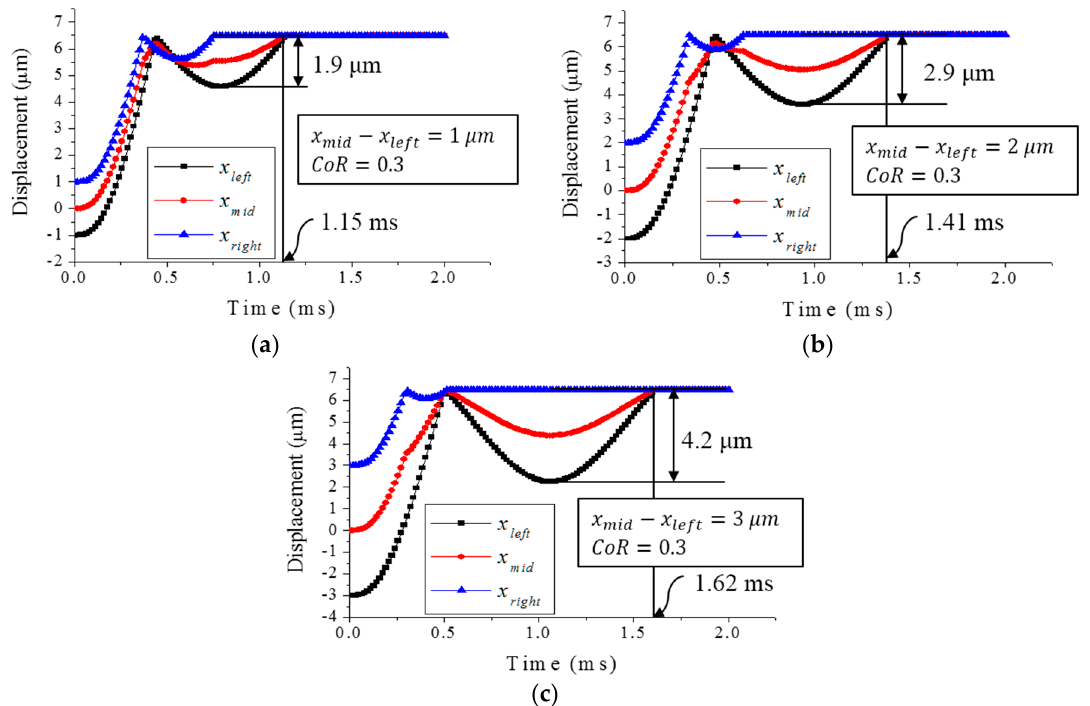
Figure 3. Analysed displacement of (cid:1876) (cid:3039)(cid:3032)(cid:3033)(cid:3047) (black square), (cid:1876) (cid:3040)(cid:3036)(cid:3031) (red circle), and (cid:1876) (cid:3045)(cid:3036)(cid:3034)(cid:3035)(cid:3047) (blue triangle). Each graph shows the result of vertical heights difference ( (cid:1876) (cid:3040)(cid:3036)(cid:3031) − (cid:1876) (cid:3039)(cid:3032)(cid:3033)(cid:3047) ) of ( a ) 1 μ m, ( b ) 2 μ m, and ( c ) 3 μ m, respectively.